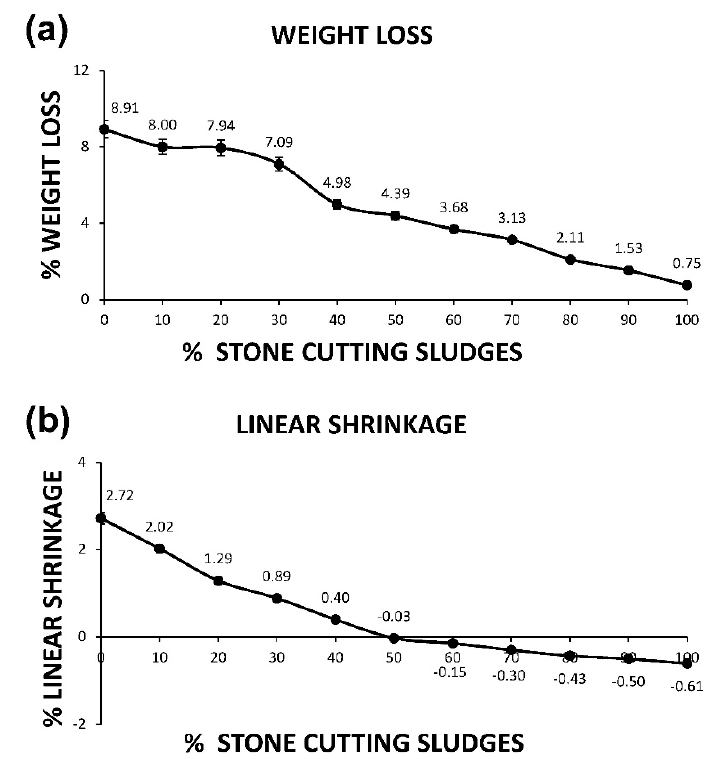
Figure 1. Graphs of the physical tests of the different groups of ceramic samples as a function of the percentage of stone cutting sludges. ( a ) Weight loss after sintering and ( b ) linear shrinkage after sintering.